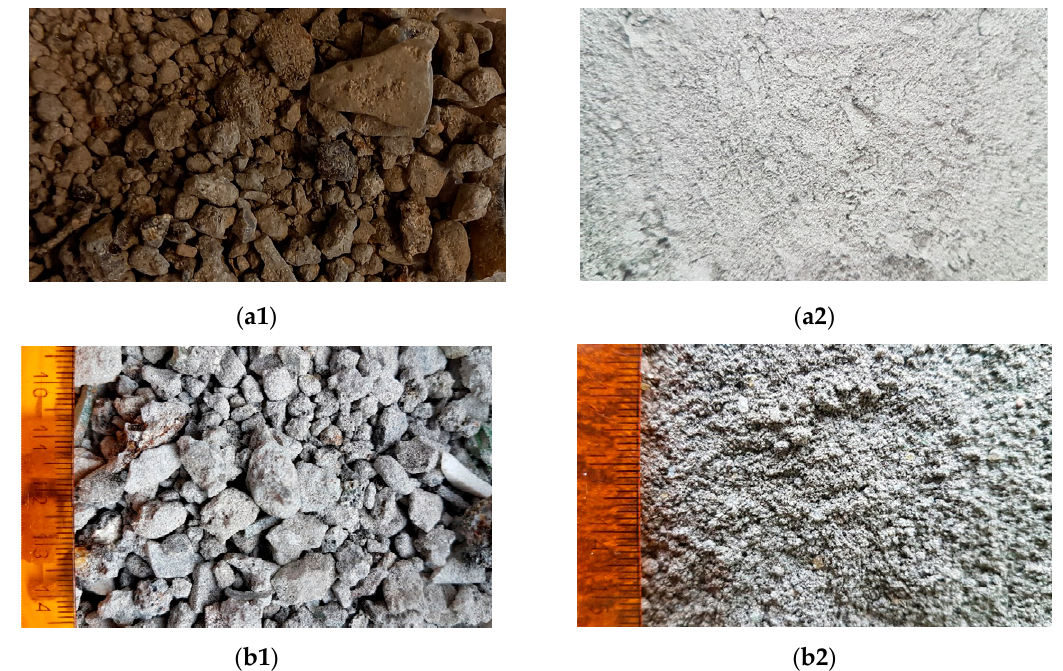
Figure 3. Analysed slags: Slag MSWI 1: ( a1 ) raw, ( a2 ) ground; Slag MSWI 2: ( b1 ) raw, ( b2 ) ground.